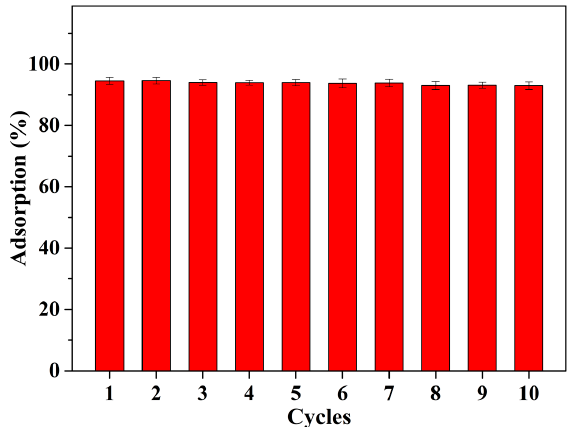
Figure 12. Adsorption performance of the Alg-EDTA in nine adsorption–desorption cycles.